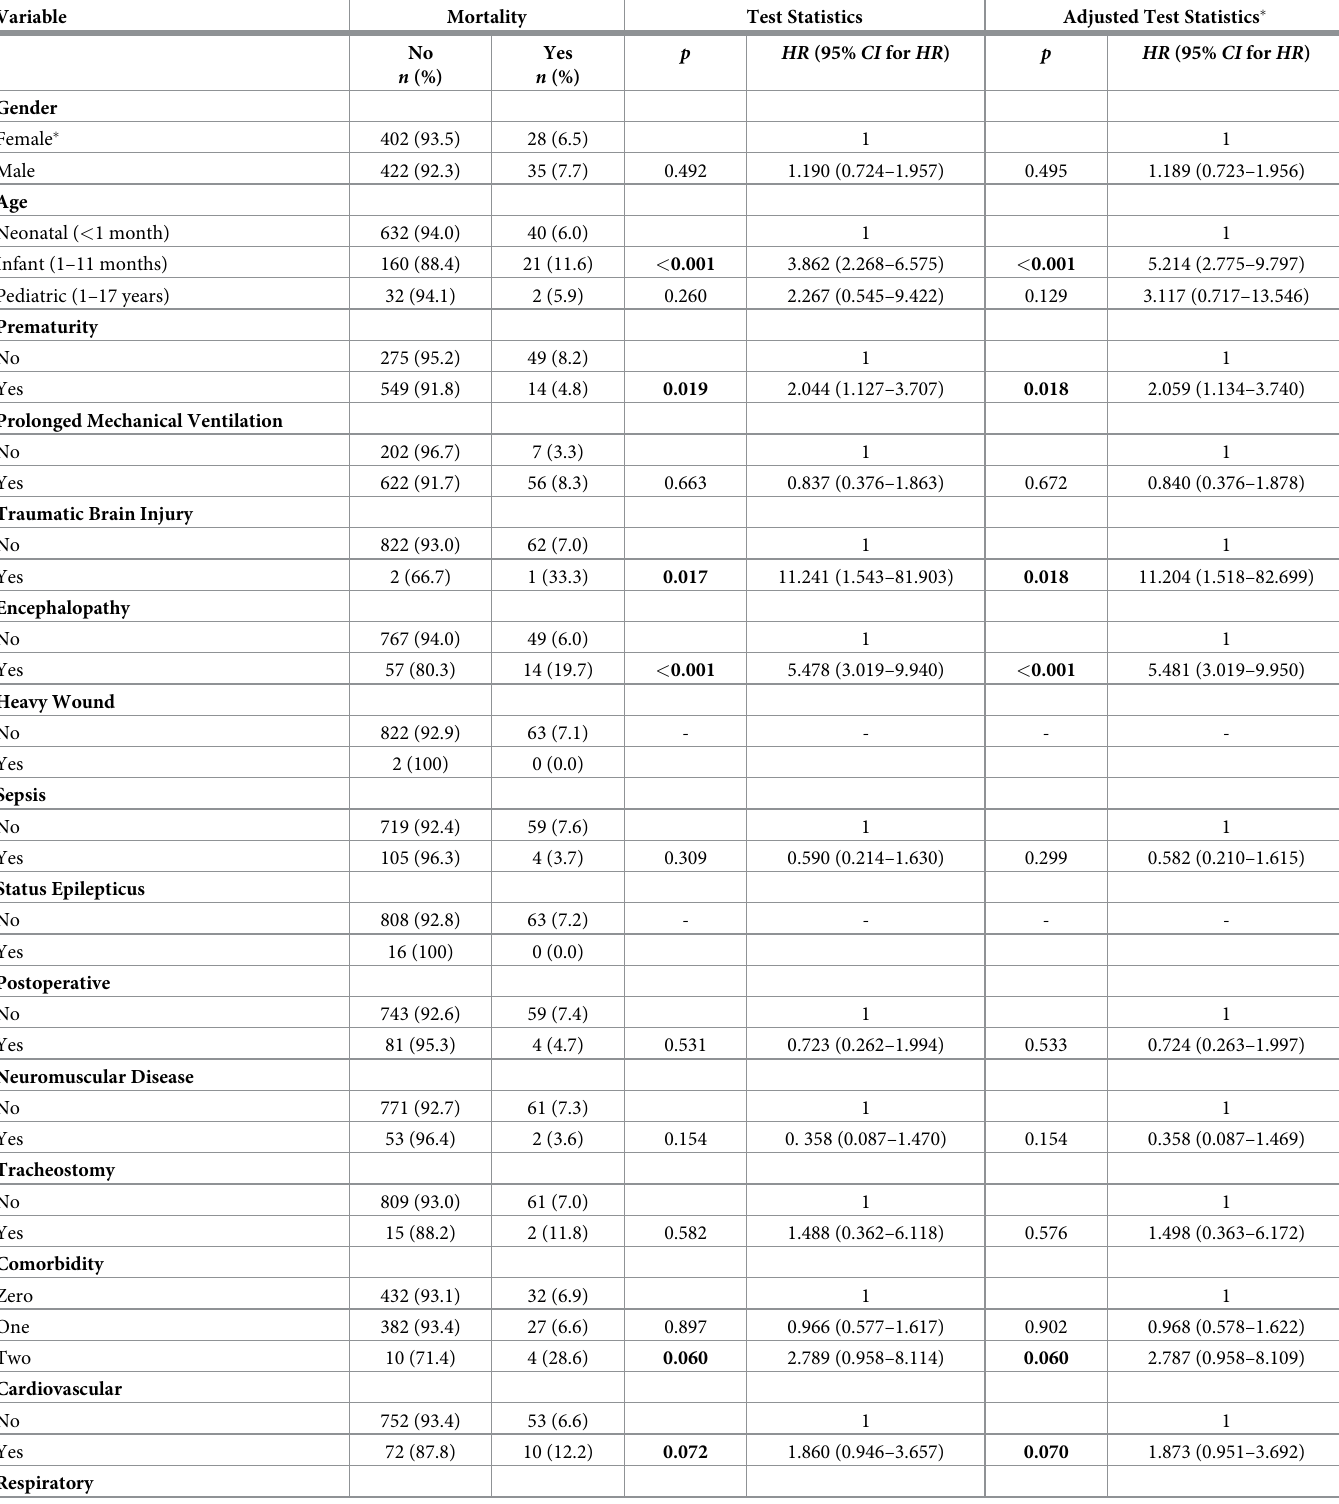
Table 3. Hazard rate and adjusted hazard rate (HR) estimations for risk factors on survival using univariate Cox proportional hazard model. Variable